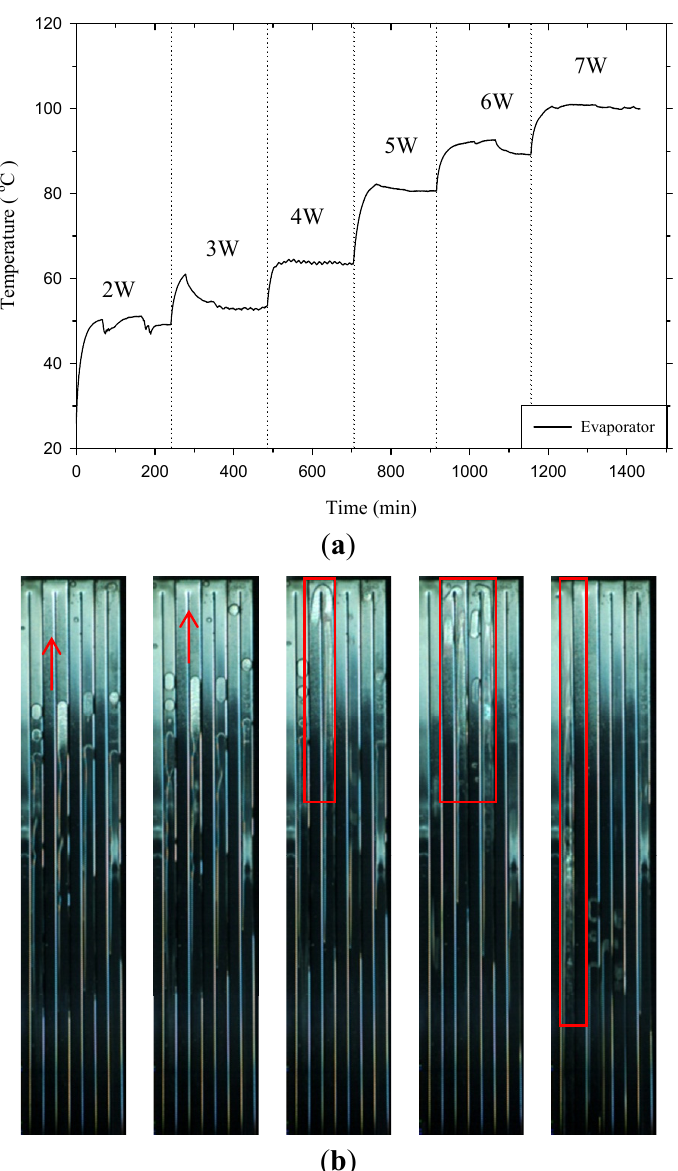
Figure 4. ( a ) Time vs. junction temperature variation of the evaporator, and ( b ) fluid flow at different time instants measured in increments of 0.033 s of a vertically oriented μ PHP having uniform channels and an input power of 4